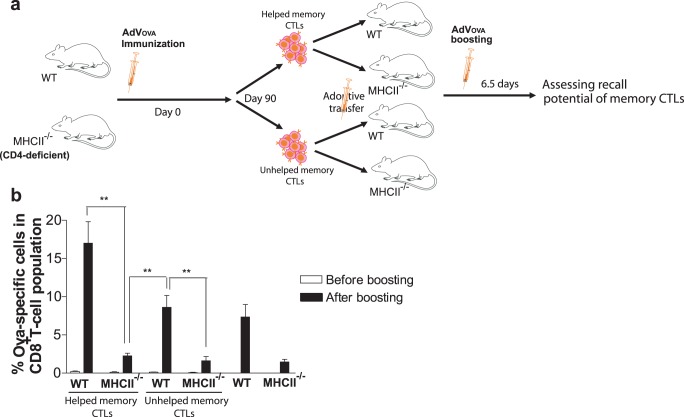
CD4+ T cell signals provided during priming and recall phase are required for optimal secondary responses.(a) A schematic protocol. After 90 days of immunization, total CD8+ T cells containing memory CTLs were purified from WT B6 mice with helped CTLs or MHCII−/− mice with unhelped CTLs, adoptively transferred in equal numbers into the naïve secondary recipients, WT and MHCII−/− mice (∼15×106/mouse), and assessed for recall potential after boosting. (b) Three days after adoptive transfer of helped or unhelped memory CTLs into naïve WT and MHCII−/− mice, all the mice groups were boosted with AdVova and monitored for the expansion of memory CTLs 6.5 days later. The values represent mean %±SD of OVA-specific tetramer+ CTLs in total CD8+ T cell population and are representative of two independent experiments with five to six mice per group. **P<0.01, versus MHCII−/− mice with helped or unhelped memory CTLs.